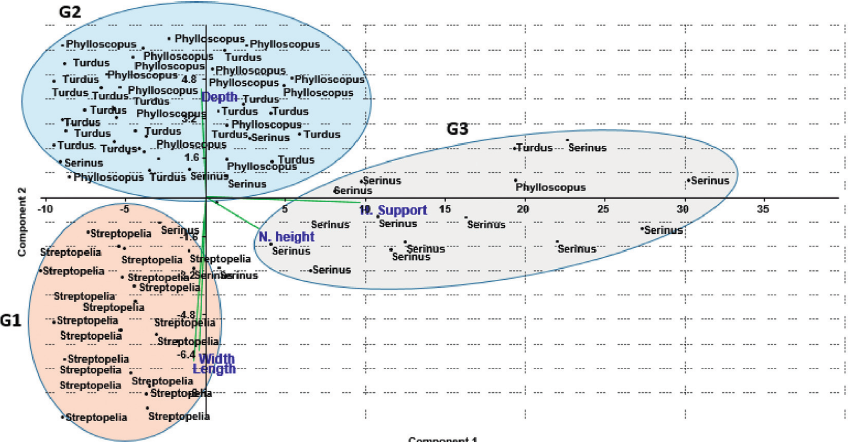
Figure 3: Principal features (depth, depth of nest cup; H. support, height of nest supporting tree; length, large axis of the nest; N. height, height of the nest above the ground; width, small axis of the nest) characterizing turtle doves ( Streptopelia turtur ) and neighbouring species nests ( Phylloscopus bonelli, Luscinia megarhynchos, Serinus serinus , and Turdus merula ) in the studied rivers at Moulouya, Morocco. Table 2: Comparison of distances separating dove nests and nests of neighbouring species using the same nesting trees (turtle dove and blackbird, Bonelli’s Warbler, and woodchat shrike), tested using the one-way ANOVA test. Parameters Number of nests on the same tree support 7 9 2 — — Number of nests on the same three species 19 25 6 — — Distances between nests on the same tree support Distances between nests on the same species of